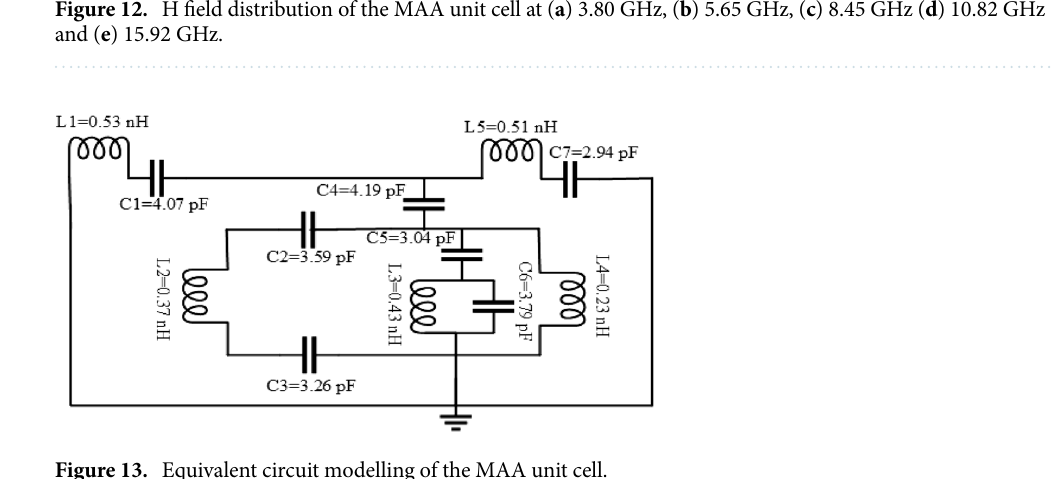
Figure 13. Equivalent circuit modelling of the MAA unit